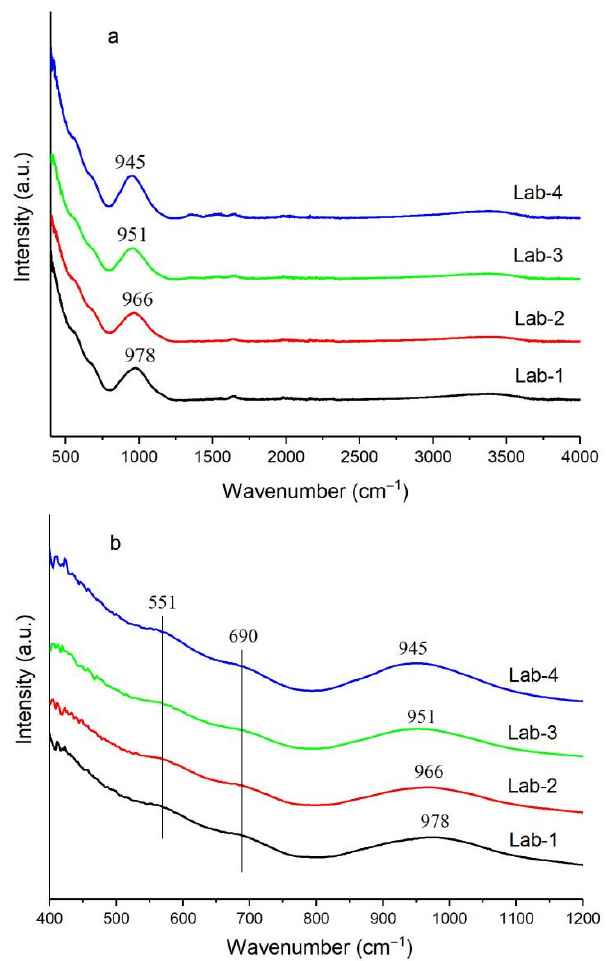
Figure 2. ATR-FTIR spectra of fresh calcined samples: ( a ) full spectra range with 400–4000 cm − 1 ; ( b ) spectra range with 400–1200 cm − 1 ).